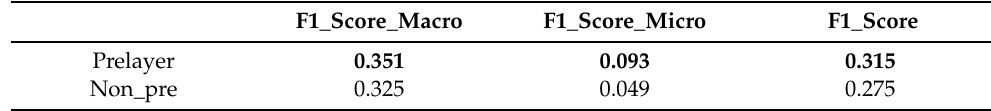
Table 3. The performance when adding